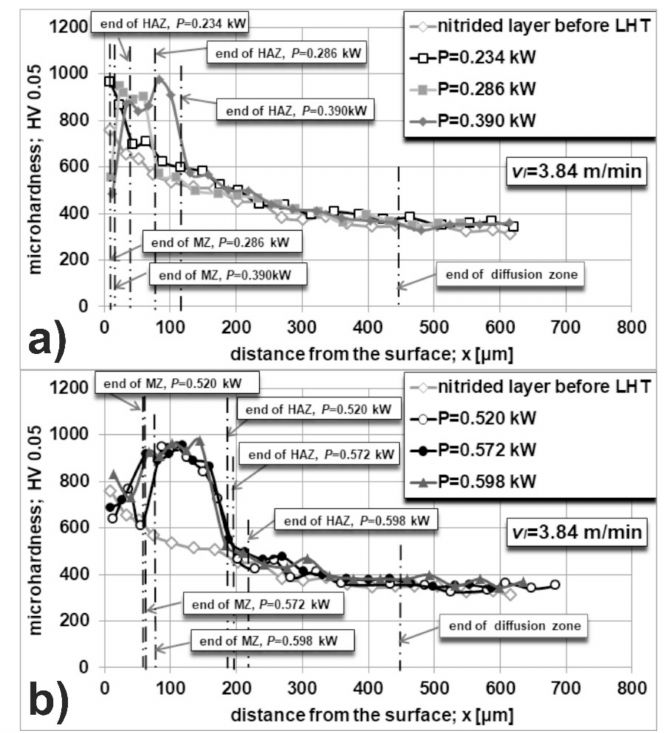
Figure 11. Microhardness profiles in single laser tracks produced on gas-nitrided 42CrMo4 steel using a scanning rate v l = 3.84 m · min − 1 and di ff erent laser beam powers: P = 0.234 kW, P = 0.286 kW, and P = 0.390 kW ( a ); P = 0.520 kW, P = 0.572 kW, and P = 0.598 kW ( b